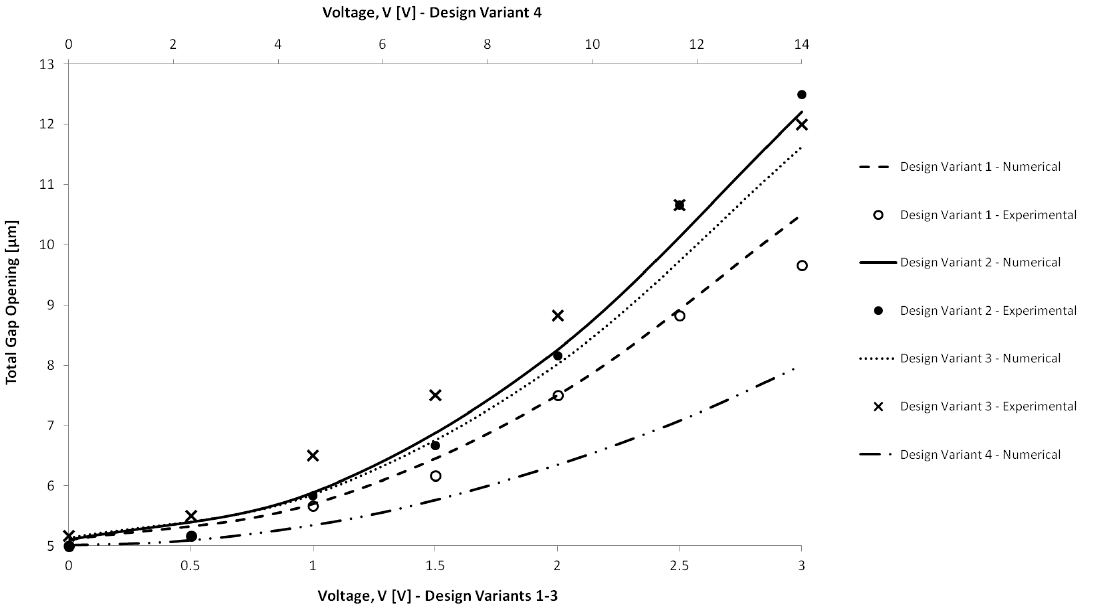
Figure 17. Comparison of the experimental and numerical results for the absolute gap opening between the arm tips of the studied microgripper design variants with applied voltage. Experimental (mean values) and numerical results are presented for Design Variants 1-3 while numerical results are shown for Design Variant 4. All design variants start from an absolute gap opening of 5 µ m, which is the gap opening in the closed